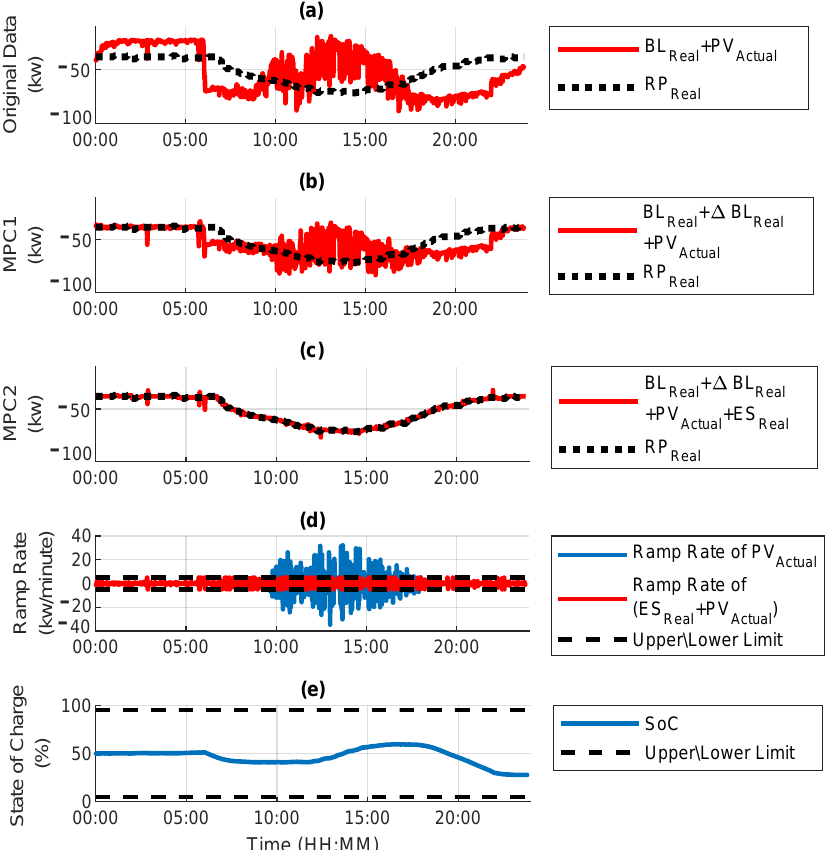
Figure 7. Day 1 real power ( a ) original data, ( b ) MPC1 simulation result, ( c ) MPC2 simulation results, ( d ) ramp rate constraint, and ( e ) energy storage SoC constraint.